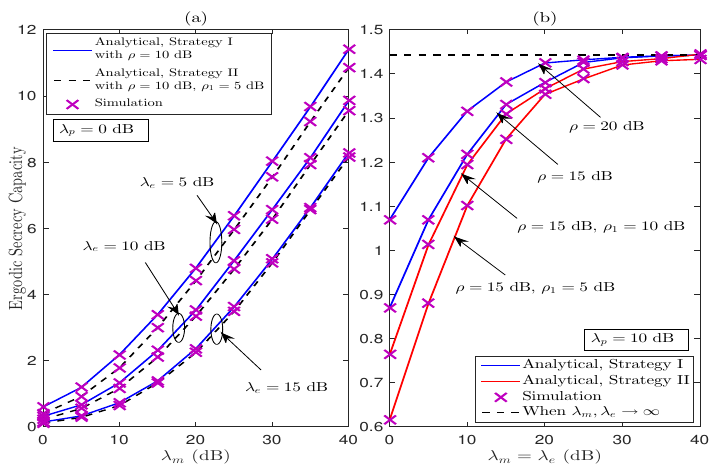
Figure 9. ESC performance for the considered system under Strategy I and Strategy